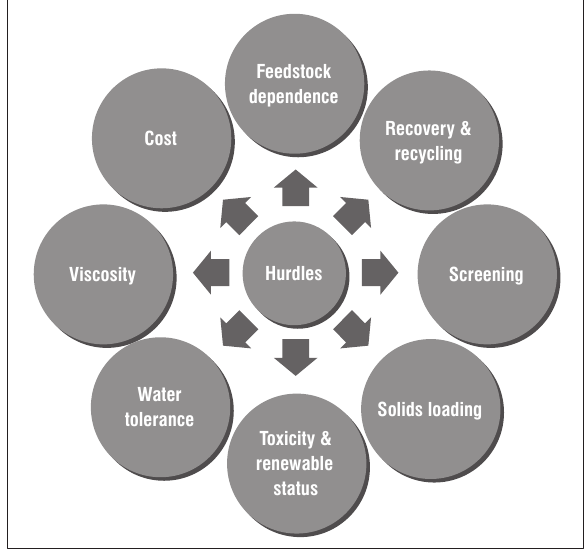
Key hurdles for the commercialisation of ionic liquid pre treat- ment of